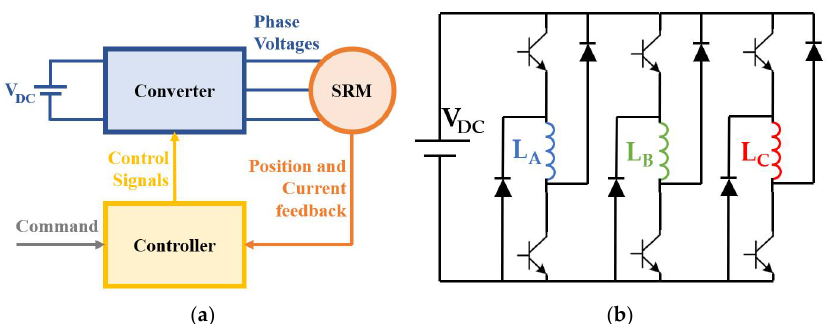
Figure 4. SRM drive: ( a ) SRM drive concept; ( b ) asymmetric bridge converter. L A–C denote to the phase inductances.